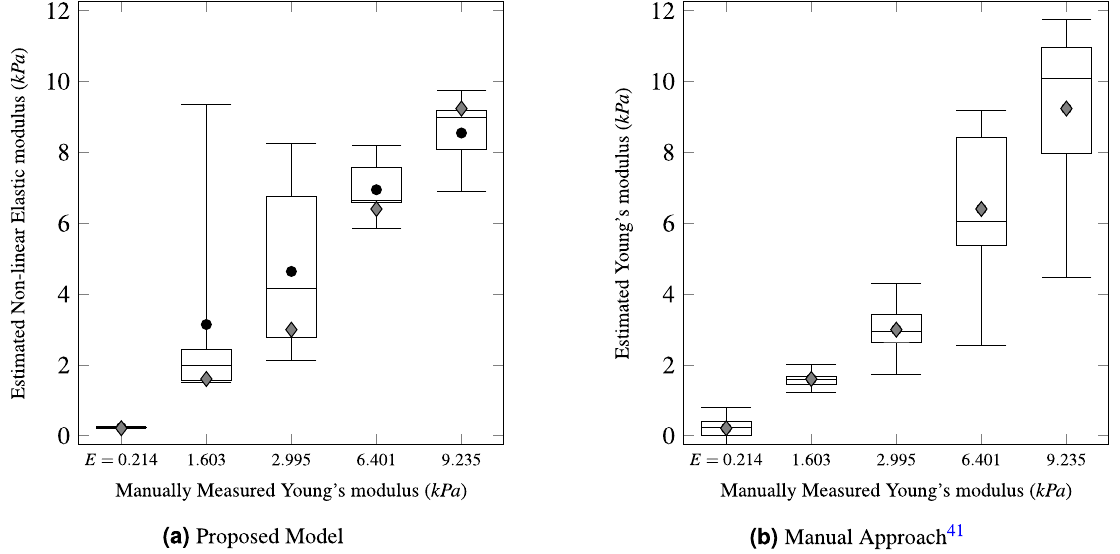
Figure 11. Distributions of the estimated elastic moduli of beads. ( a ) presents the distributions of non-linear elastic moduli of beads estimated by the proposed method, and ( b ) shows the distributions of Young’s moduli of beads predicted by the existing method. The X-axes indicate the manually measured Young’s moduli of the five types of beads, and the Y-axes refer to the estimated elastic moduli of 20 beads for each bead type. The three horizontal lines indicate the first, second, and third quartiles of the estimated elastic moduli, respectively. The tops and bottoms of the whiskers refer to the maxima and minima of the elastic moduli, respectively. Circular dots denote the average elastic moduli. Diamonds mark ground